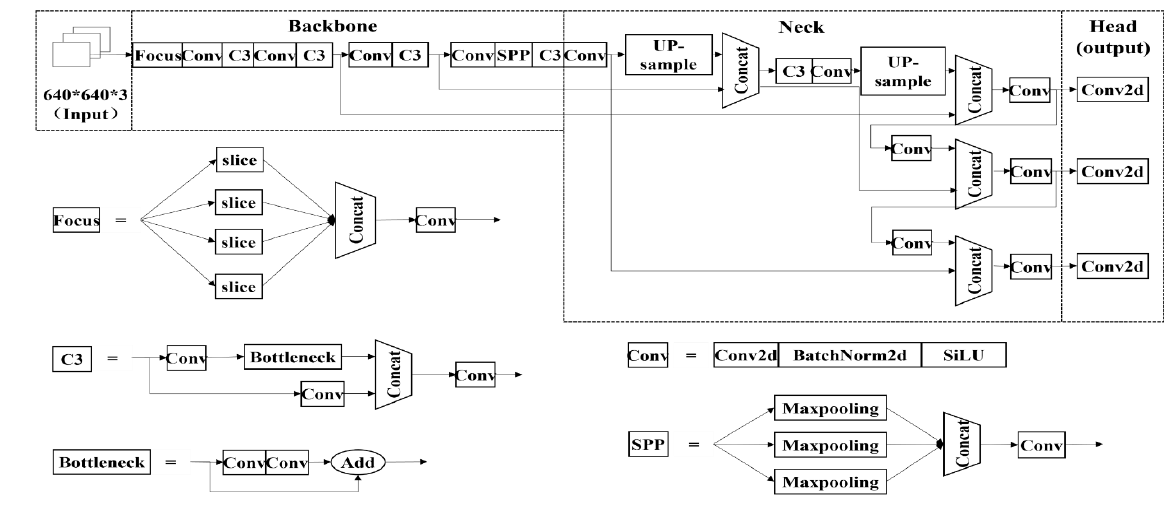
Figure 3. Design of the YOLOv5s detection model.